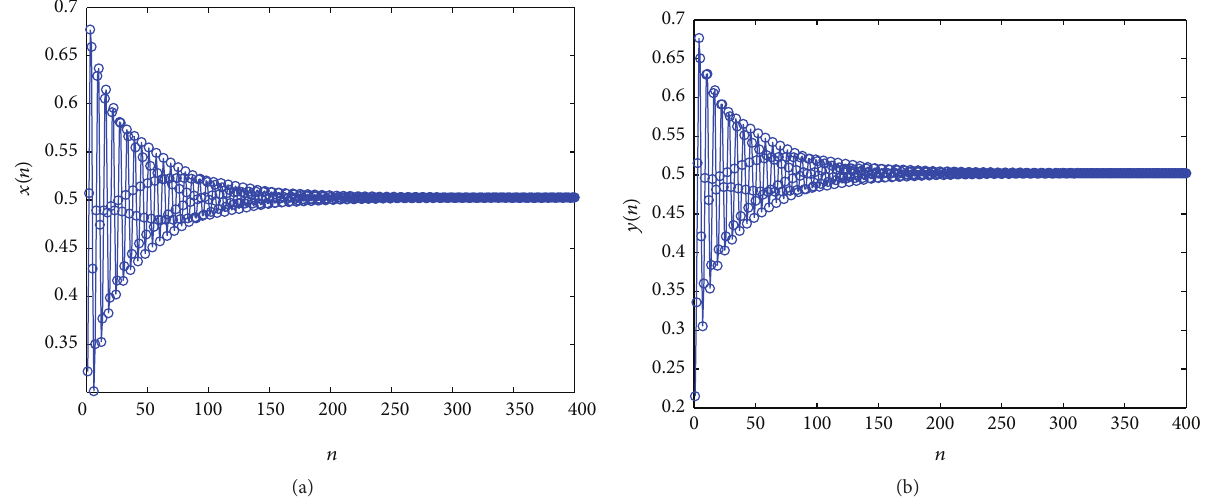
Figure 2: Time history diagram of the controlled delayed species model (11) for 𝑘 1 = −0.05 and 𝑟 = 2.01 ; the initial values are [𝑥(0) = 0.2,𝑦(0) = 0.2]